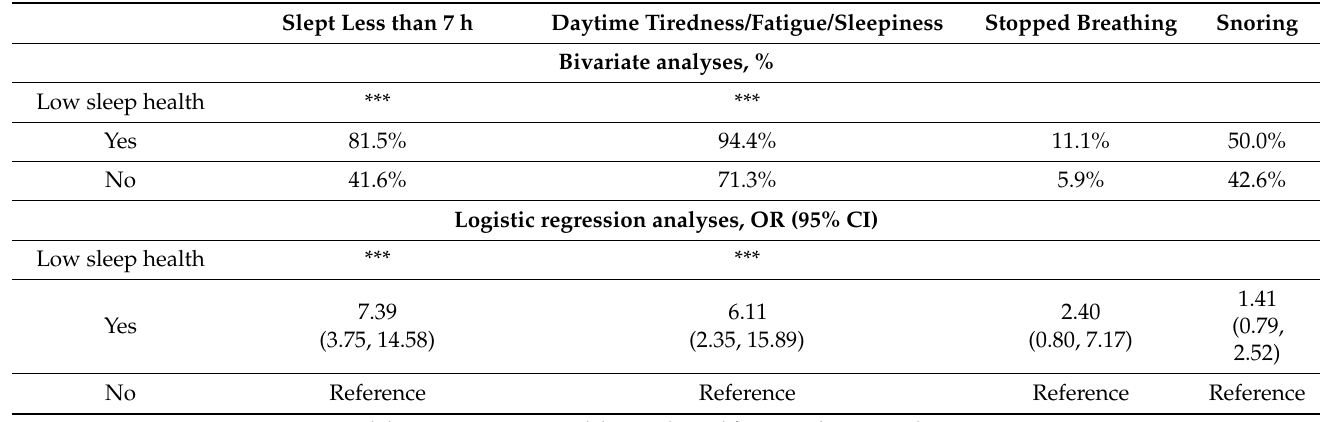
Table 2. Bivariate and adjusted associations between pandemic-related reduction in quality and hours of sleep with sleep health characteristics.